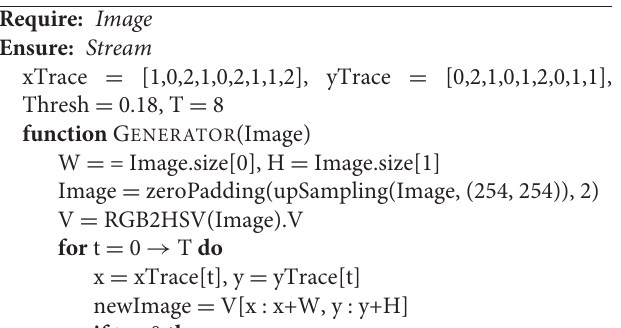
Algorithm 1 : ODG event